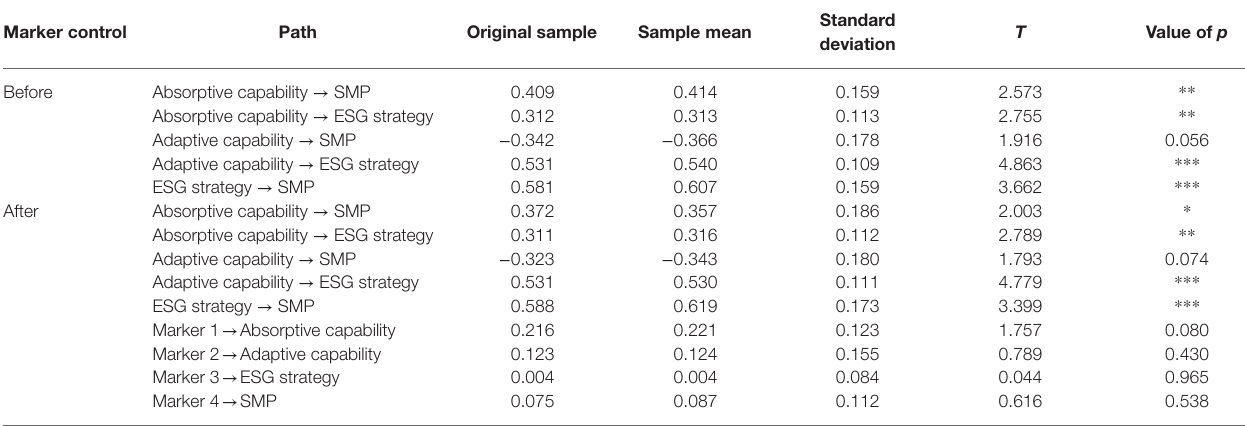
TABLE 1 | Marker variable analysis results. Marker control Path Original sample Sample mean